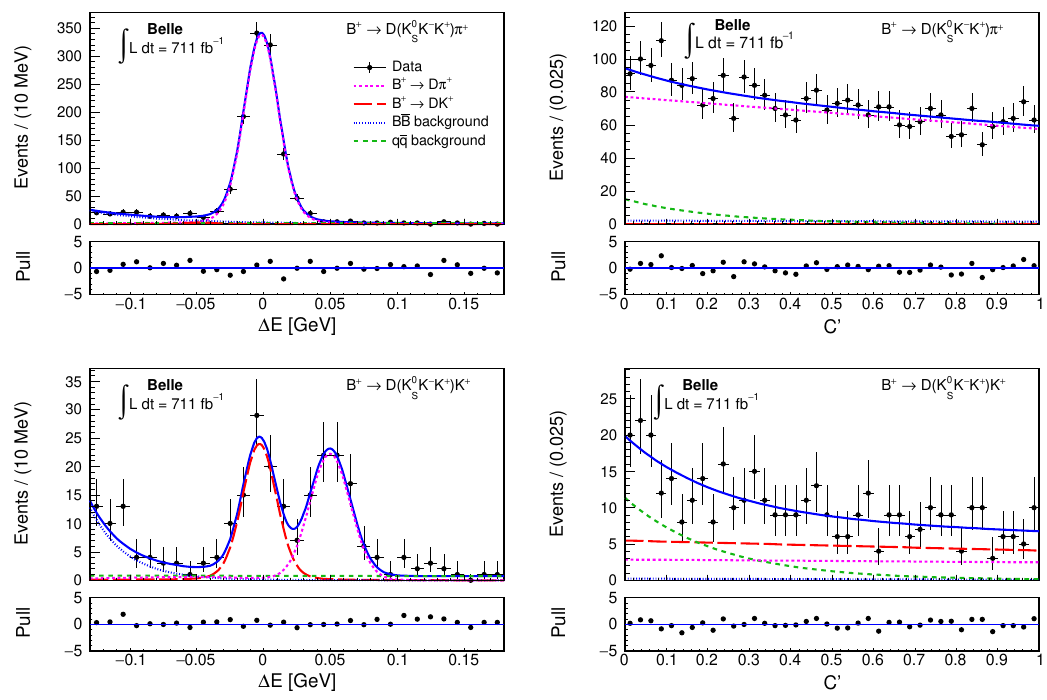
K − K + ) π + and (bottom) S